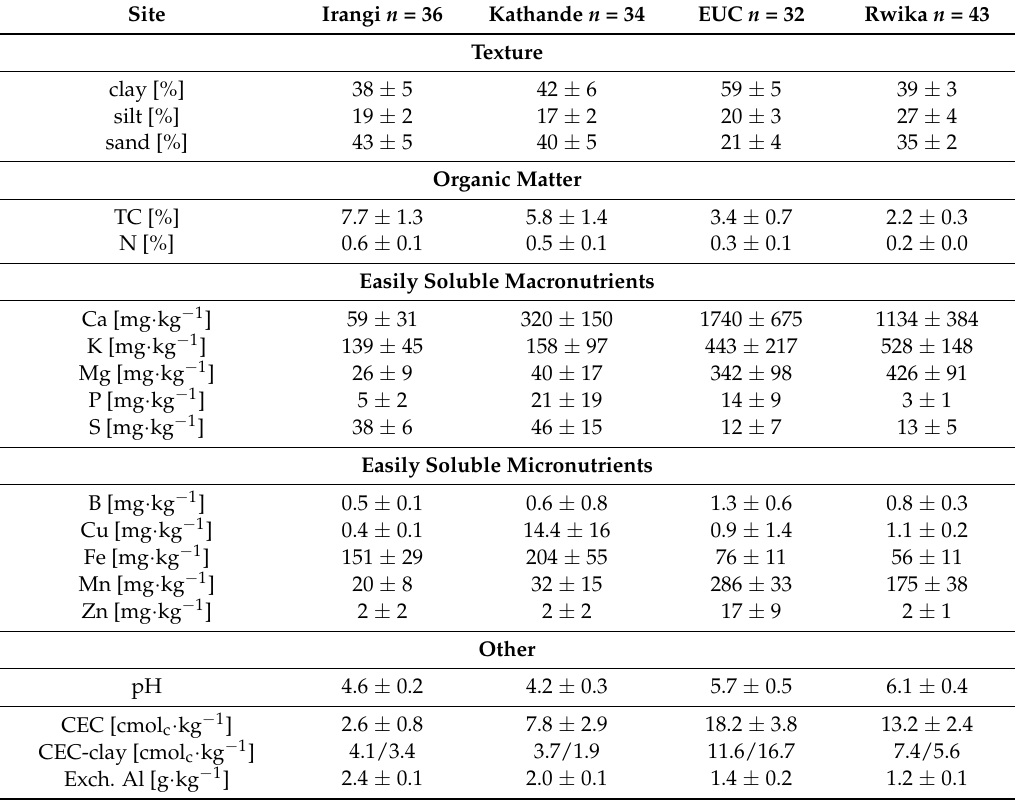
Table 1. Soil data (0–20 cm) for the studied sites. Mean ± standard deviation for all variables except CEC-clay; for CEC-clay the value for the deepest horizon in two soil profiles at each site is presented. Please note that any Fe oxides are in the clay fraction. EUC = Embu University College, TC = total carbon, N = nitrogen, and CEC = cation exchange capacity, Exch. Al = exchangeable